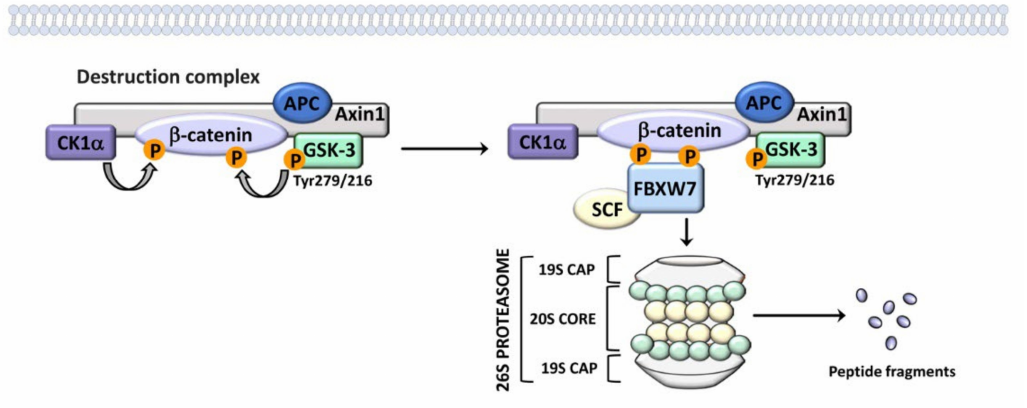
Figure 3. Active GSK-3 isoforms are components of the “destruction complex” which targets β -catenin to degradation through the proteasome. The “destruction complex” also includes Axin1, APC, CK1 α , and β -catenin. CK1 α targets β -catenin on the Ser45 residue, thereby priming β -catenin for phosphorylation by GSK-3 α / β on multiple aminoacidic residues (Ser33/37, Thr41). Phosphory- lated β -catenin is recognized by the FBXW7/SCF complex and degraded through the proteasome. When Wnt signaling is not inhibited, β -catenin migrates to the nucleus, where it upregu- lates specific transcriptional programs leading to the expression of proto-oncogenes such as cyclin D1, c-Myc, vascular endothelial growth factor (VEGF), and matrix metalloproteinase-7 (MMP-7)